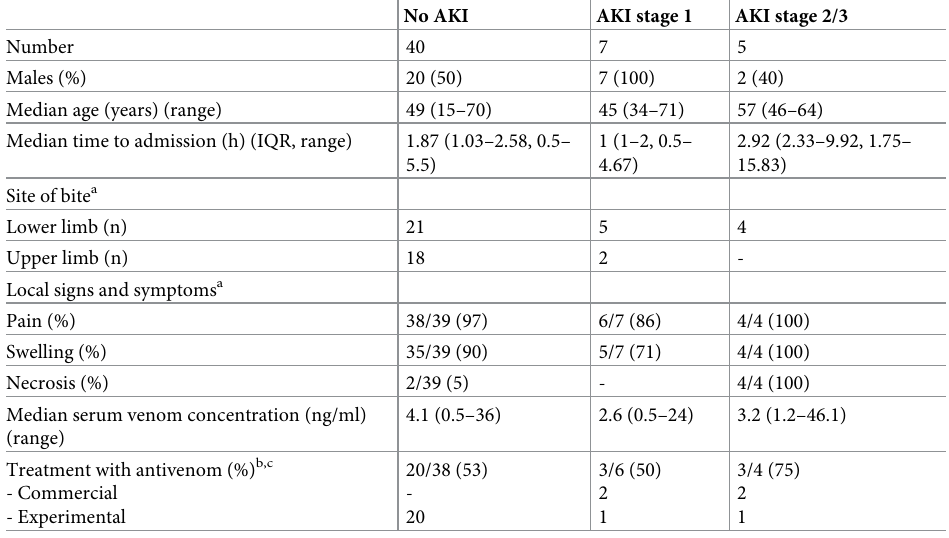
Table 1. Patient demographic and clinical